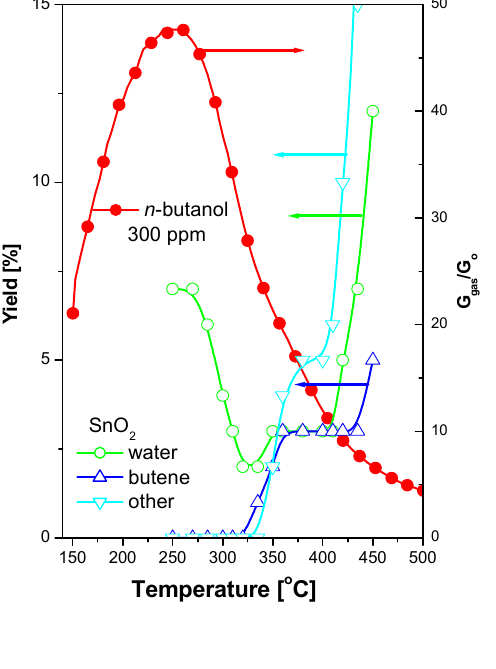
in the presence of n 2